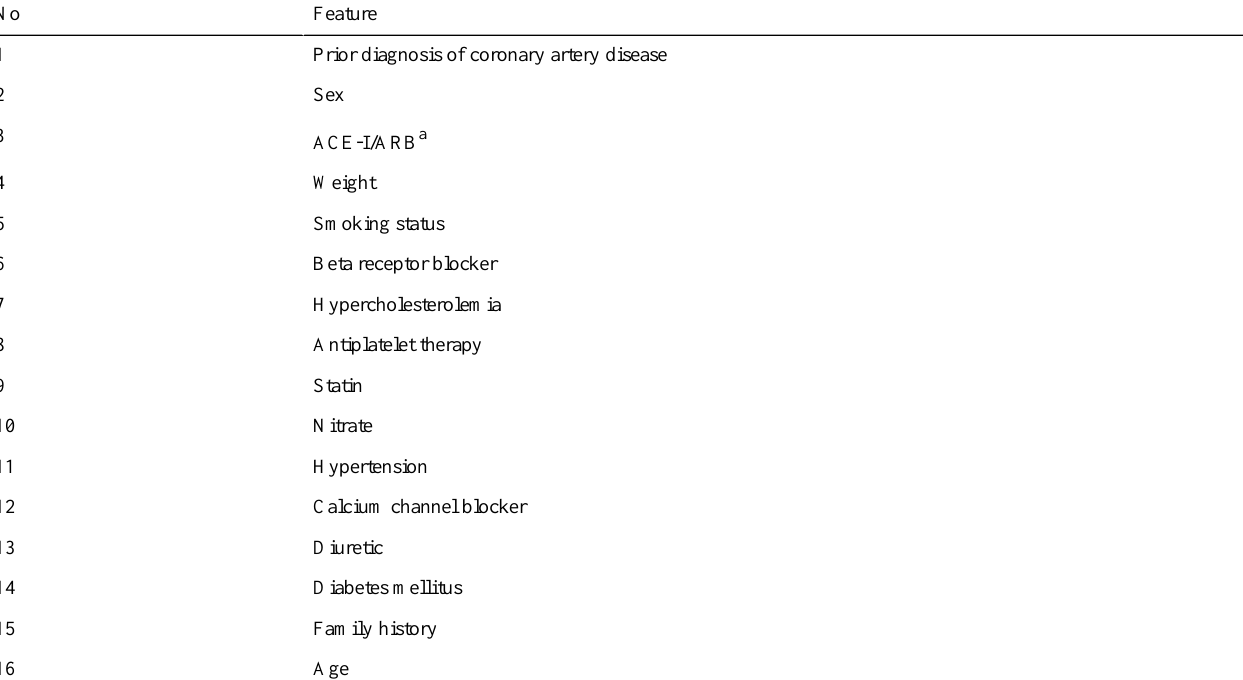
Table 3. Feature rankings.